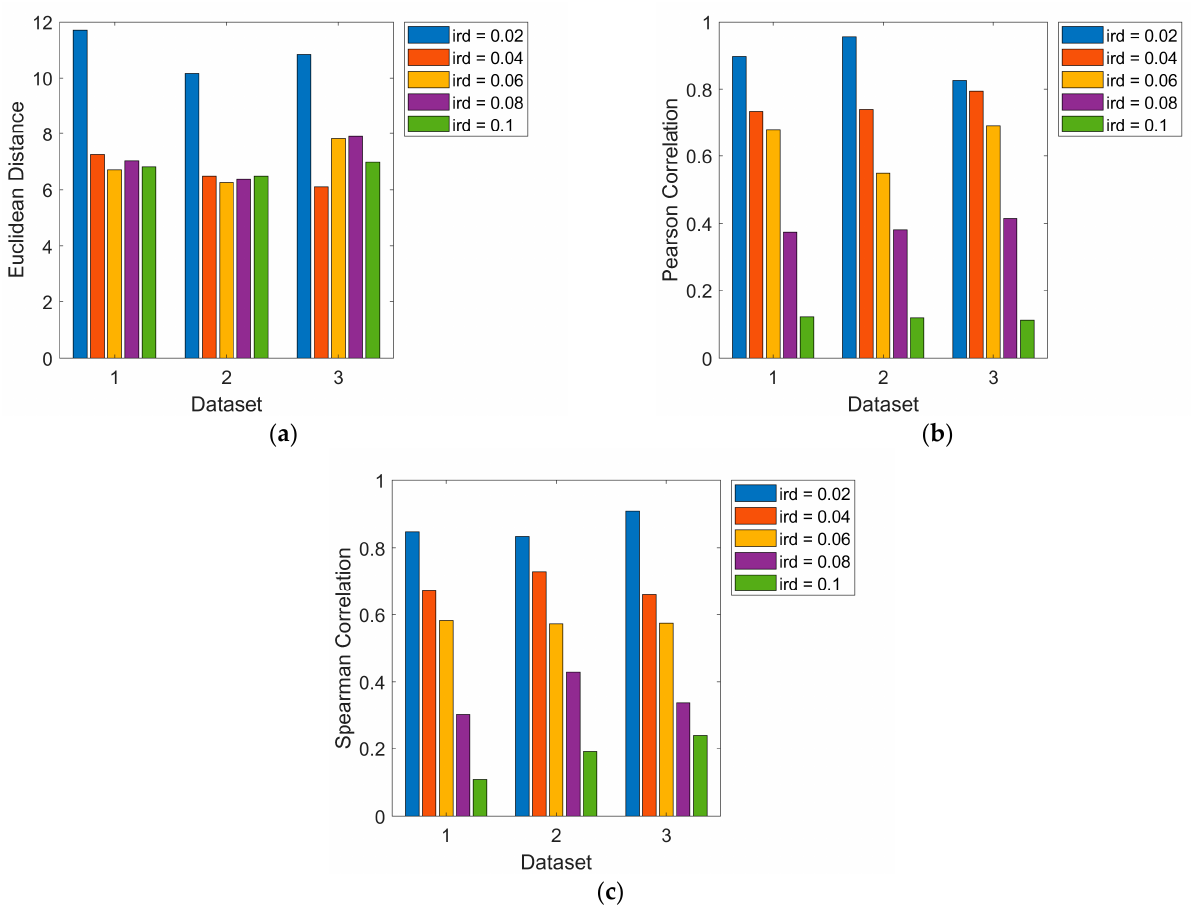
Figure 11. Analysis of controlling the parameters of the designed method using ( a ) Euclidean distance, ( b ) Pearson correlation, and ( c ) Spearman